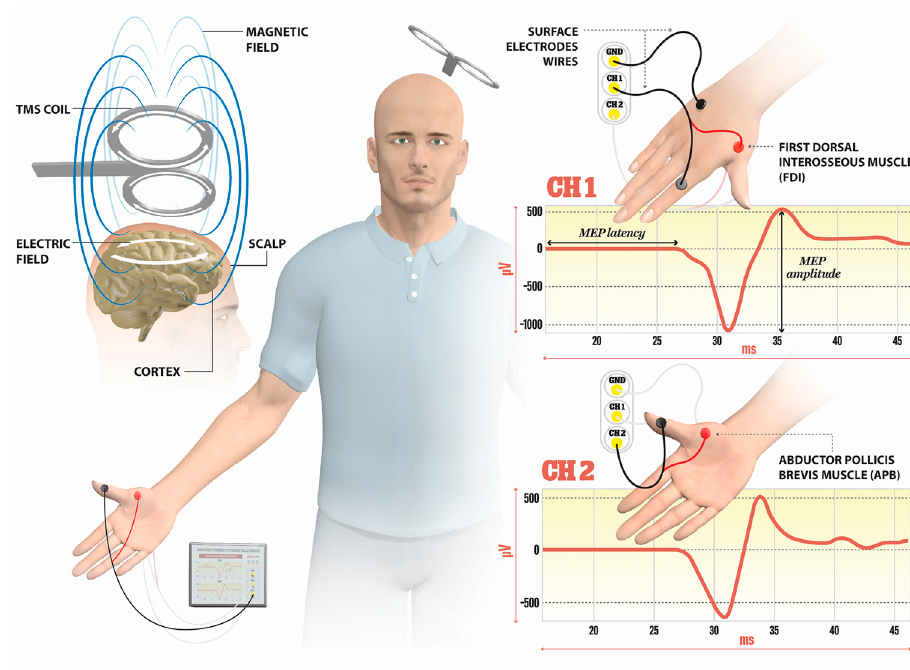
Figure 1. Illustration of the direction of current flows in a magnetic coil and the induced current in the brain tissue. An electric field is induced perpendicularly to the magnetic field. The magnetic coil is positioned over the M1 cortex, and surface electrodes are on the target muscles, here shown for the first dorsal interosseus (FDI) and abductor pollicis brevis (APB). Elicited MEP responses are detected at channels Ch1 for FDI, and Ch2 for APB muscle. The illustration is the property of the School of the Medicine University of Split, Department of Neuroscience, Laboratory for Human and Experimental Neurophysiology).